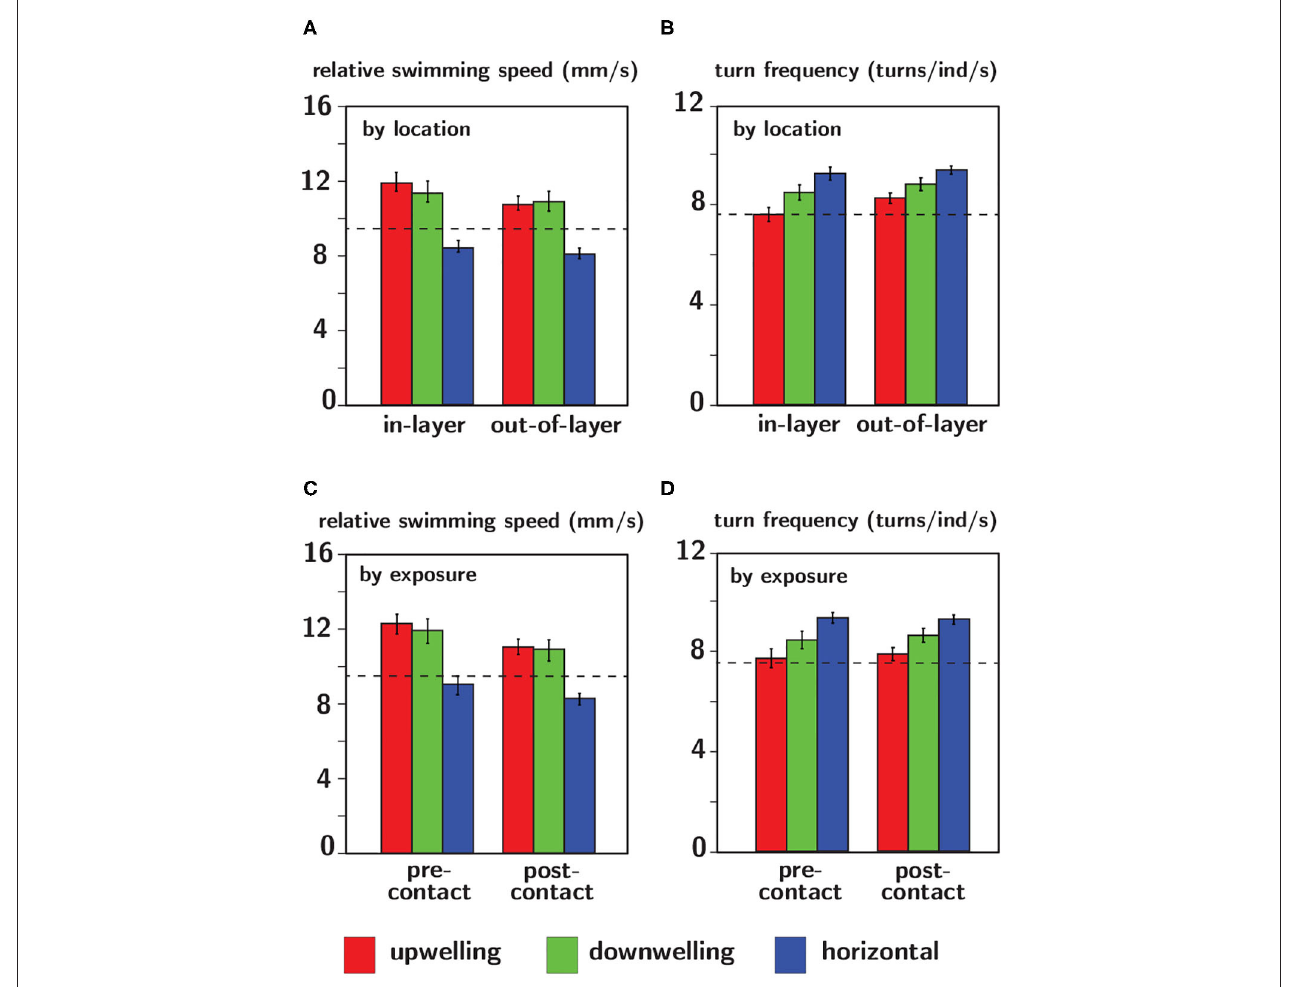
FIGURE 11 | Relative swimming speed (A,C) and turn frequency (B,D) analyzed by location (A,B) and exposure (C,D) for upwelling (red), downwelling (green), and horizontal (blue) shear flow orientations. The dashed black lines indicate average values of each respective parameter in no-flow (control) conditions. Error bars span ± one standard error.